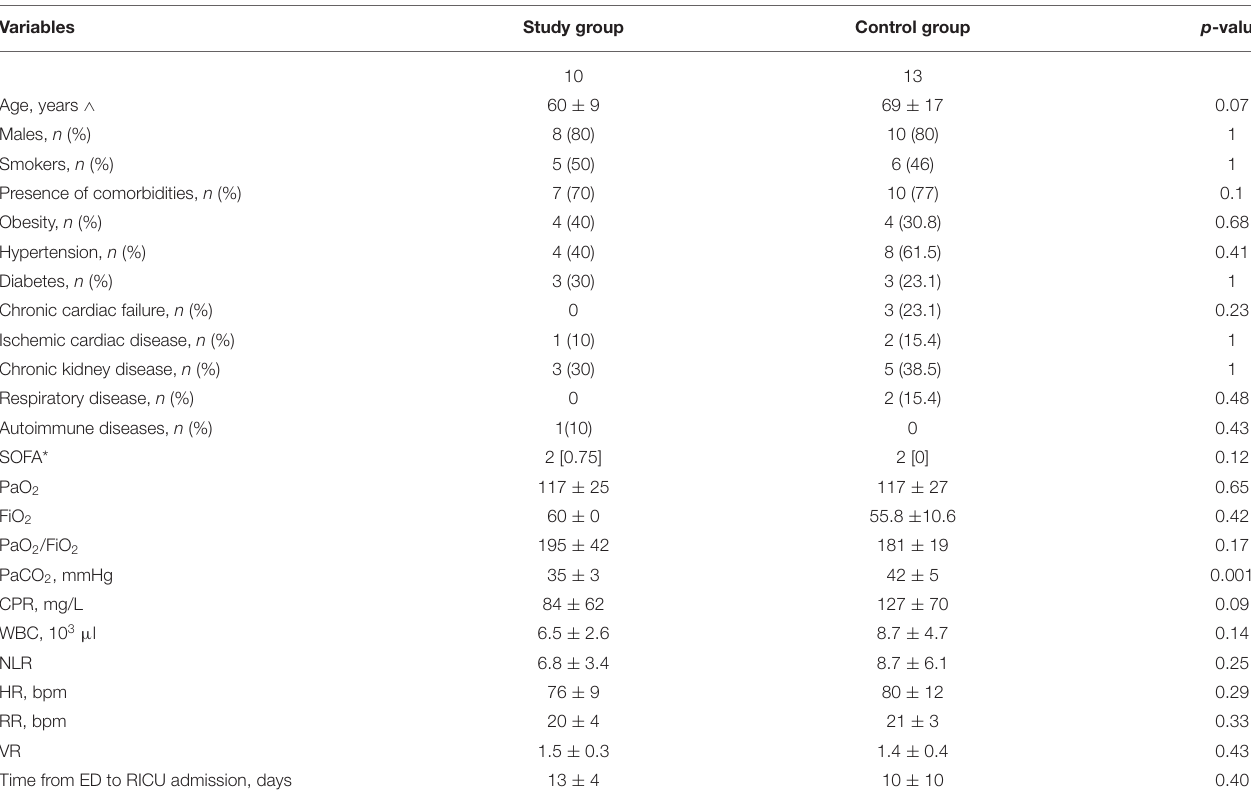
TABLE 2 | Demographic, physiological, and clinical characteristics of successful patients at admission. Variables Study group Control group